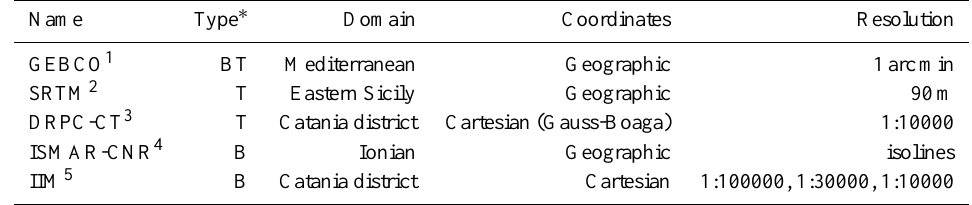
Table 6. Synthetic list of the topo-bathymetric datasets.